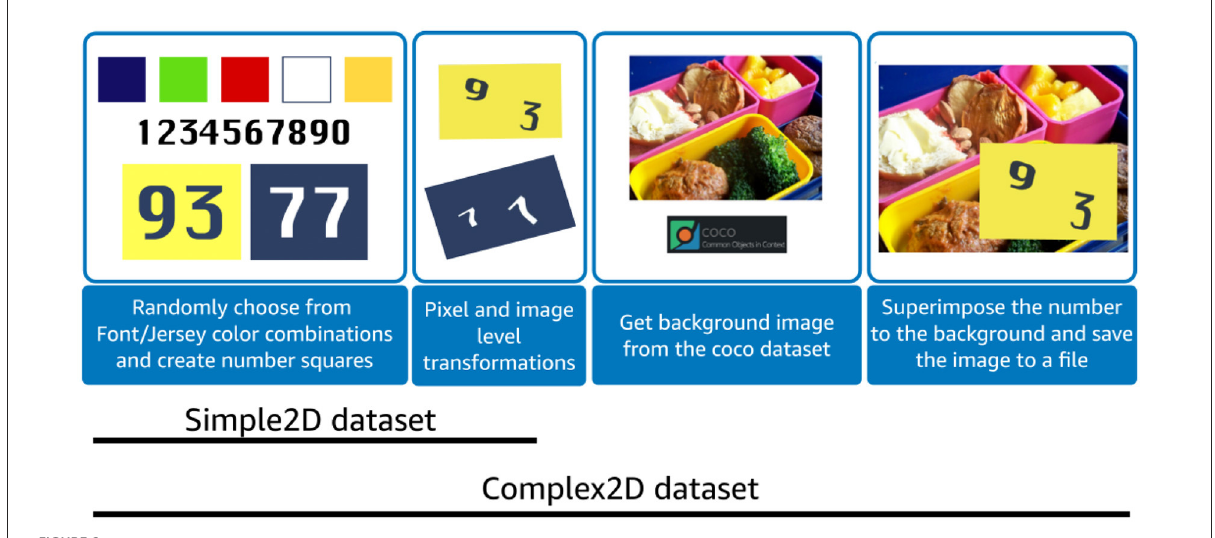
FIGURE6 Synthetic data generation with Simple2D and Complex2D. Simple2D dataset was generated by creating numbers in football dataset jersey colors and fonts. Several augmentations (Table 1) were applied on these numbers to get Simple2D dataset. The numbers from this dataset were randomly sampled and randomly placed on COCO dataset images to form Complex2D